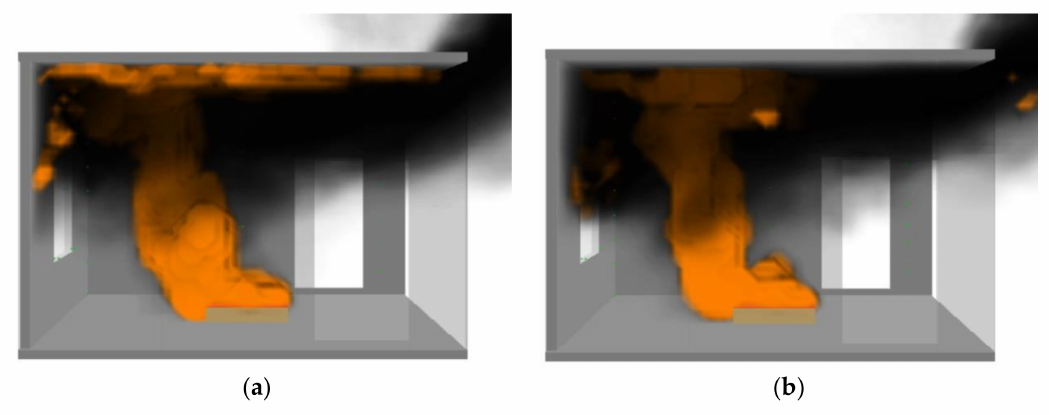
Figure 27. Gas distribution under window sprinkler conditions: ( a ) 50 s, ( b ) 150